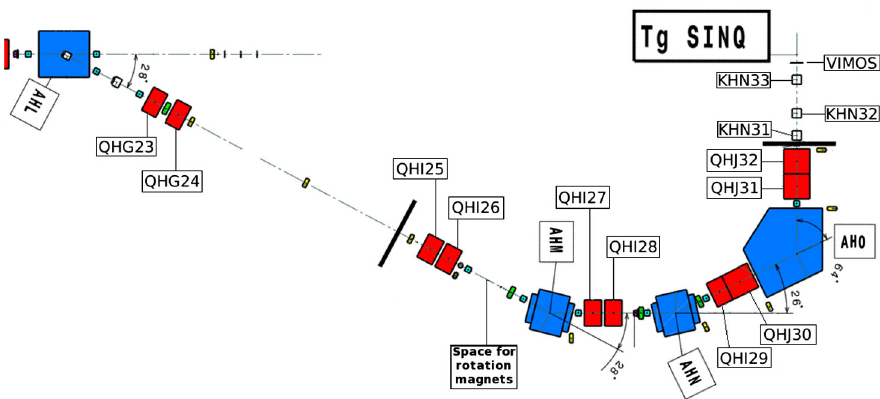
FIG. 1. Layout of the SINQ beam line with a possible location for a proton beam rotation system composed of two dipoles. The horizontal gap of the magnets is: AHM — 94.0 mm, AHN — 94.0 mm, AH0 — 102.0 mm. The half-radius of the quadrupoles is: QHI — 129.0 mm, QHJ — 110.0 mm.